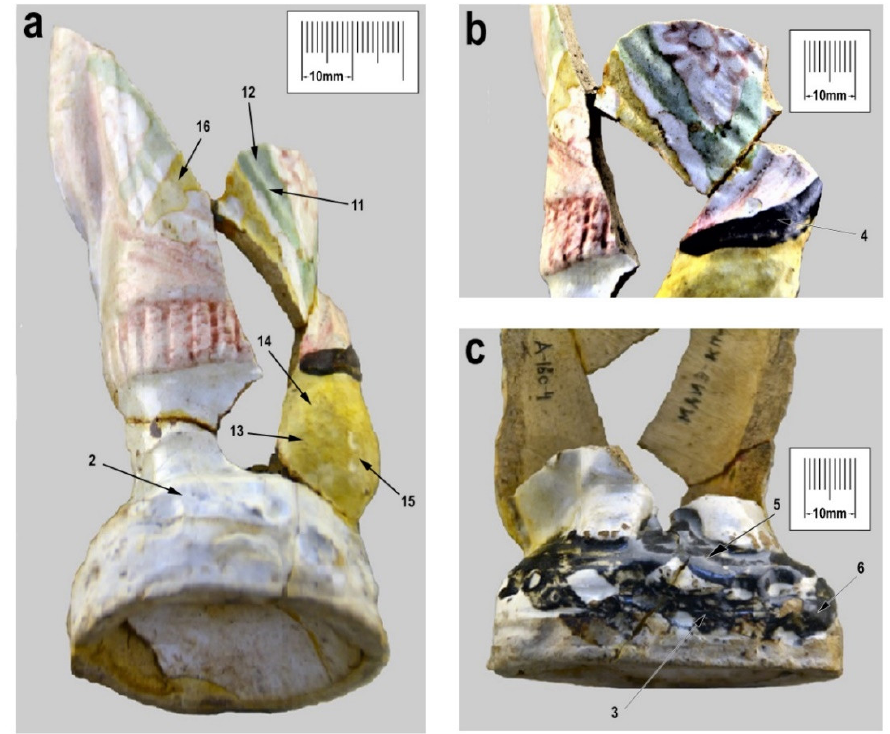
Figure 3. Polychrome figurine from Anan’evka walled settlement. Middle ( a , b ) and lower ( c ) parts of the figurine. Thin arrows correspond to the points of taking the pXRF spectra.